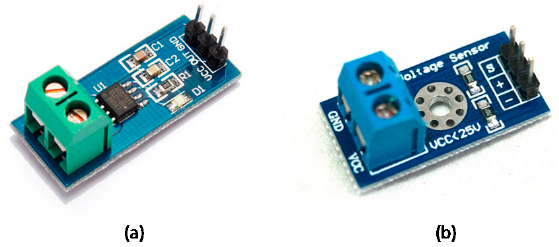
Figure 14. ( a ) Hall-effect current sensor; and, ( b ) Voltage sensor.